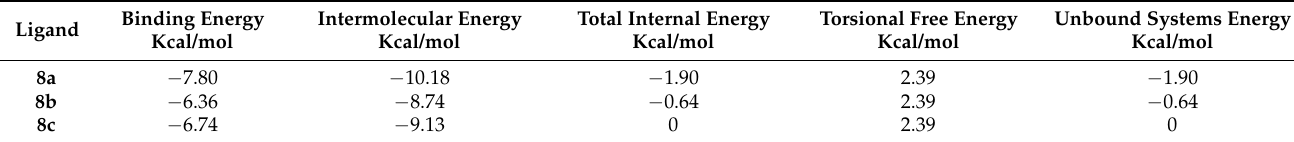
Table 3. Molecular docking analysis of AChE and ligand complexes.